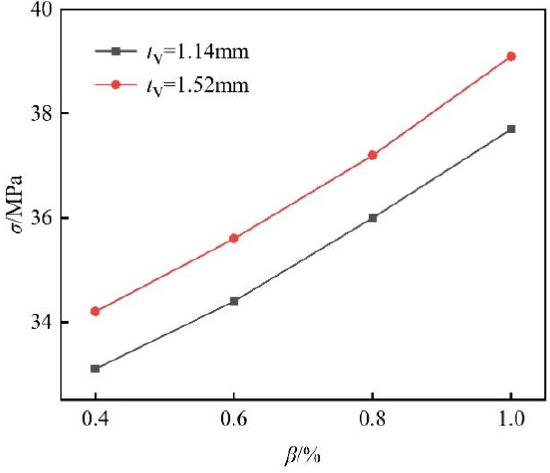
Figure 10. Maximum coupling stress versus cold-bending curvature curves.